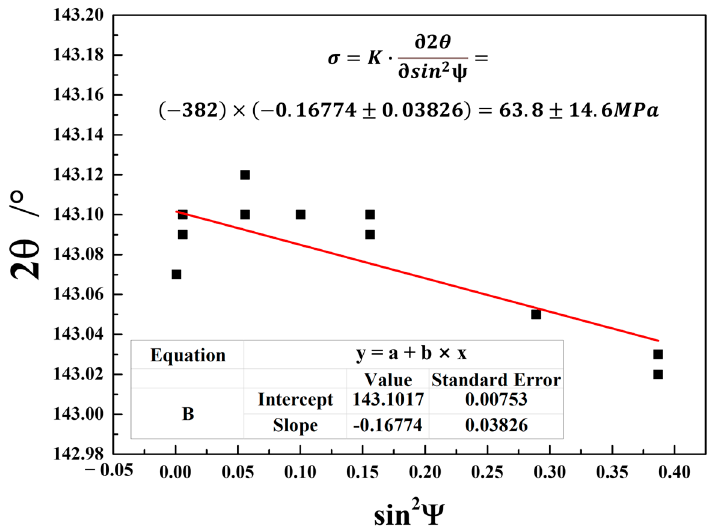
Figure 5. XRD surface stress measurement data for the basic parameter of P0. The stress values corresponding to these data were obtained from the plot of 2 θ versus sin 2 ψ